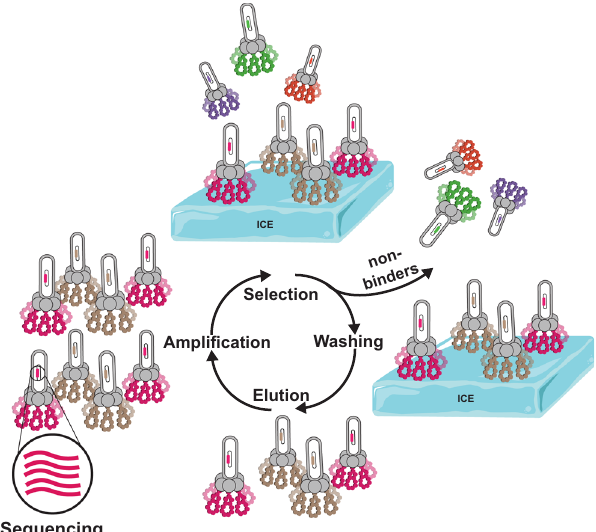
Fig. 1 Phage display. Schematic illustration of the phage display process used for the identi fi cation of ice-binding